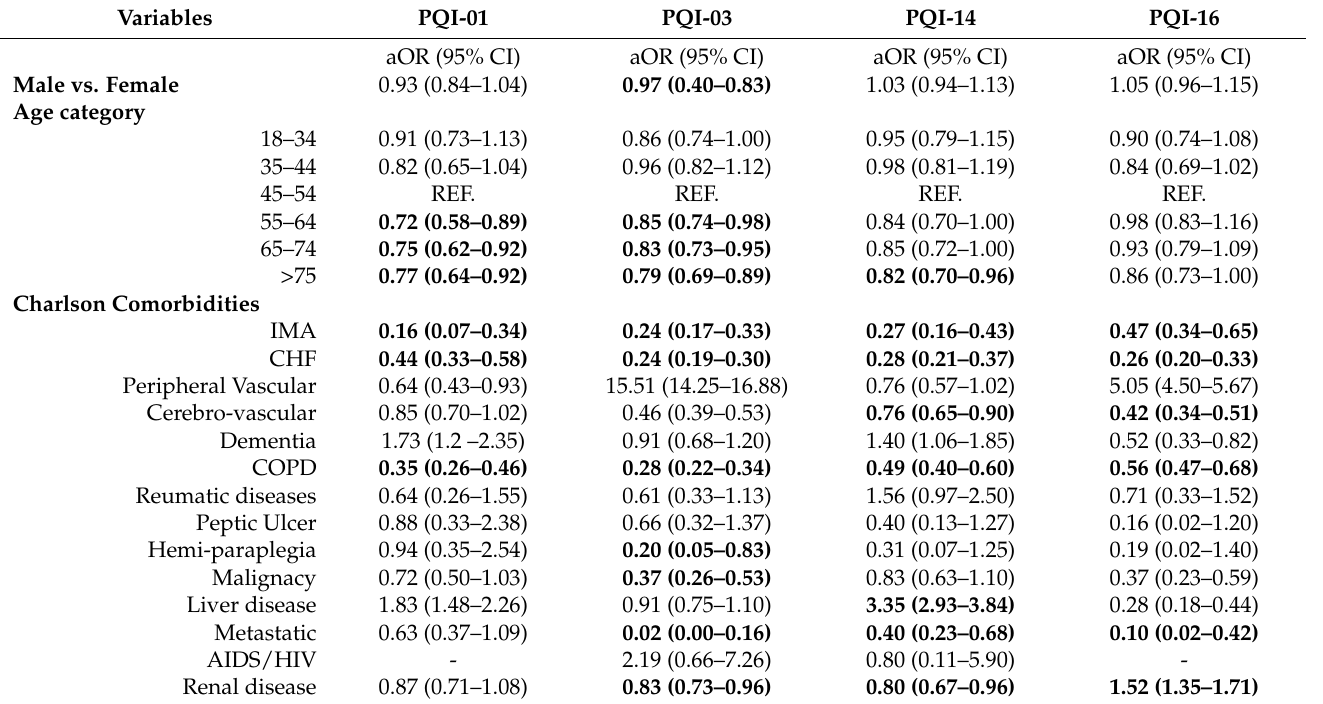
Table 2. Multivariable logistic regression models to evaluate DRPH-associated